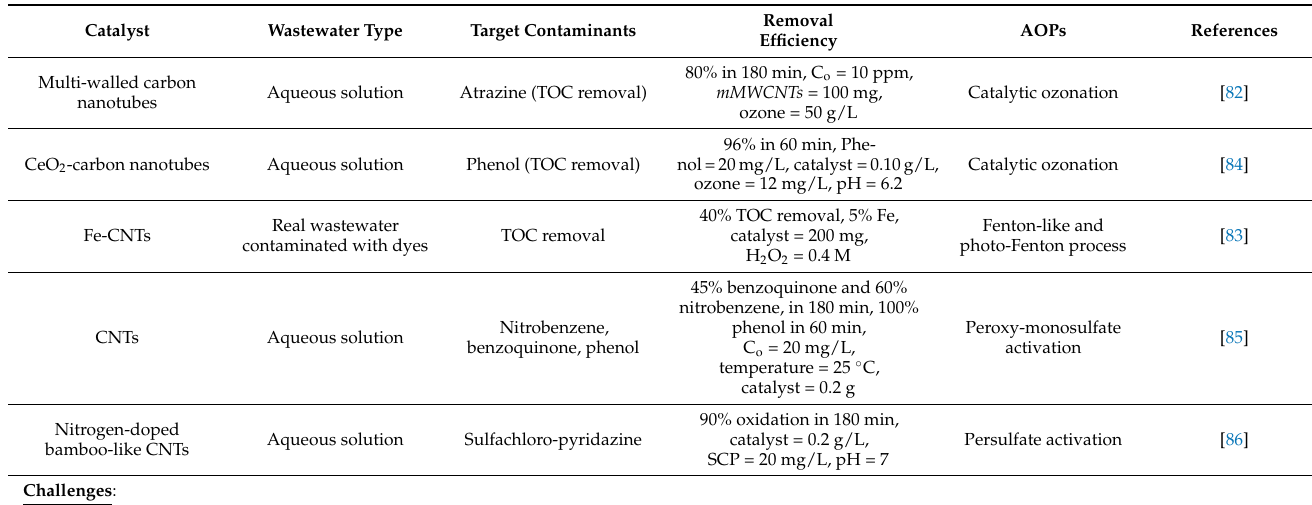
Figure 6. Degradation pathways of ATZ on MWCNTs. Reprinted with permission from Ref. [67]. Table 7. Carbon nanomaterials and nanotubes as nanocatalysts in AOPs for wastewater